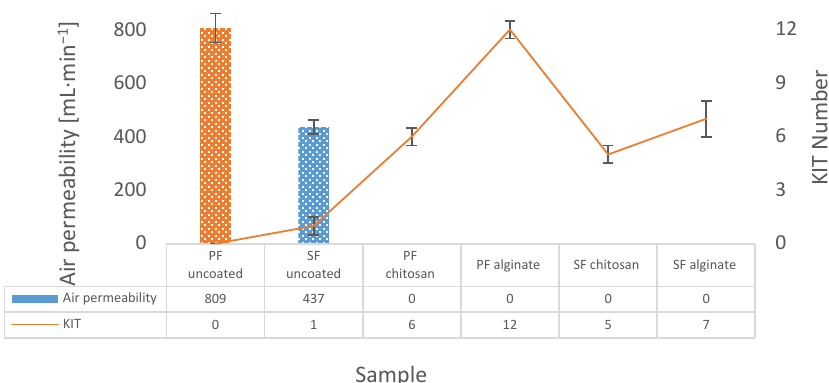
Figure 2. Air-permeability ( n = 15) and grease-resistance values (KIT test, n = 9) for uncoated and coated primary-fiber (PF) and secondary-fiber (SF) paper.